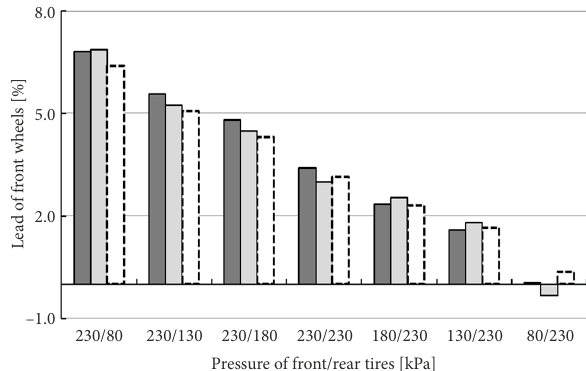
Pressure of front/rear tires Figure 3. Lead of front wheels of the tractor values for 4WD drive mode for different front and rear tire pressures: dark-coloured columns - when the tractor was engine braking; light-coloured columns - when the tractor was not braking; white-coloured columns with dotted lines - calculated on the basis of Equation (14)